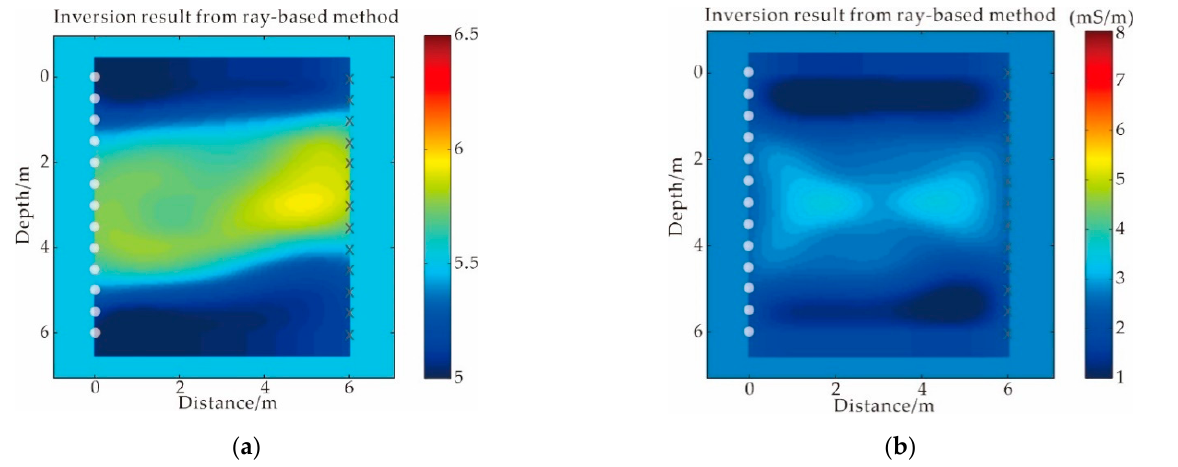
Figure 6. The initial model based on ray theory: ( a ) relative permittivity; ( b ) conductivity.